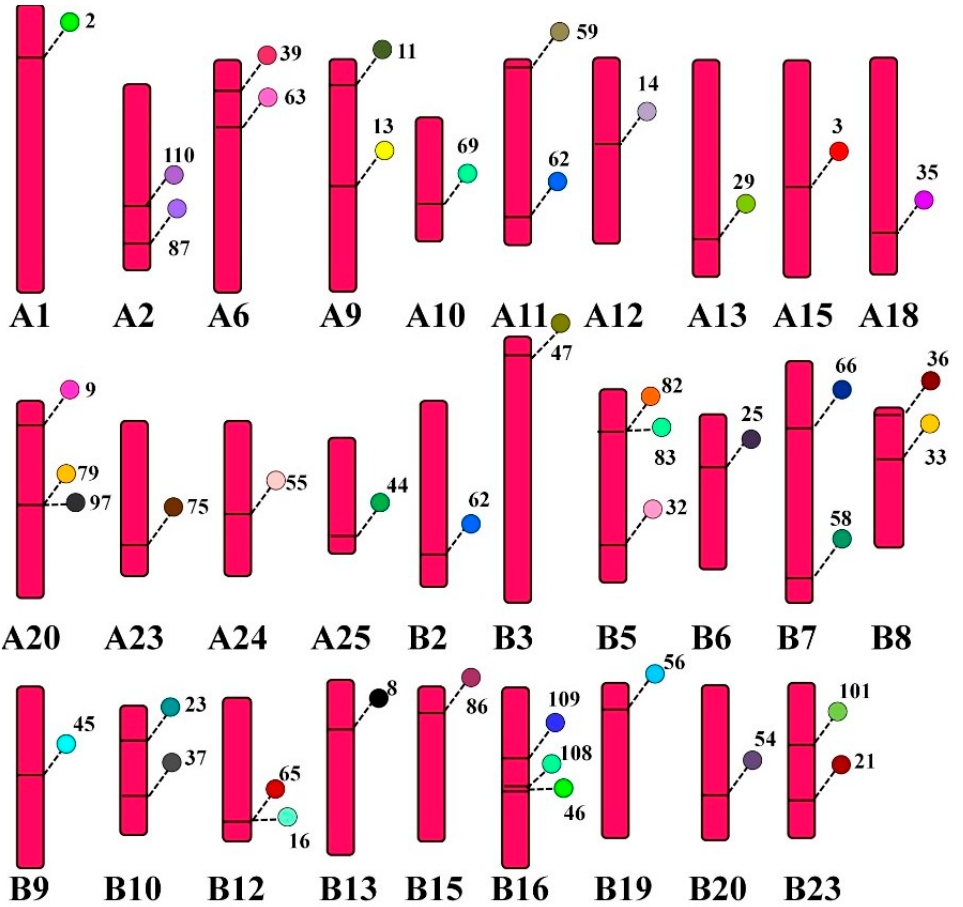
Figure 7. Location of CcTrim genes on 29 chromosomes loci marked with different colors. PhonoGram a web-based tool was used to visualize location and the chromosome number was indicated at the bottom of each chromosome. The gene locus is a label with particular TRIM number and is shown using a unique color.